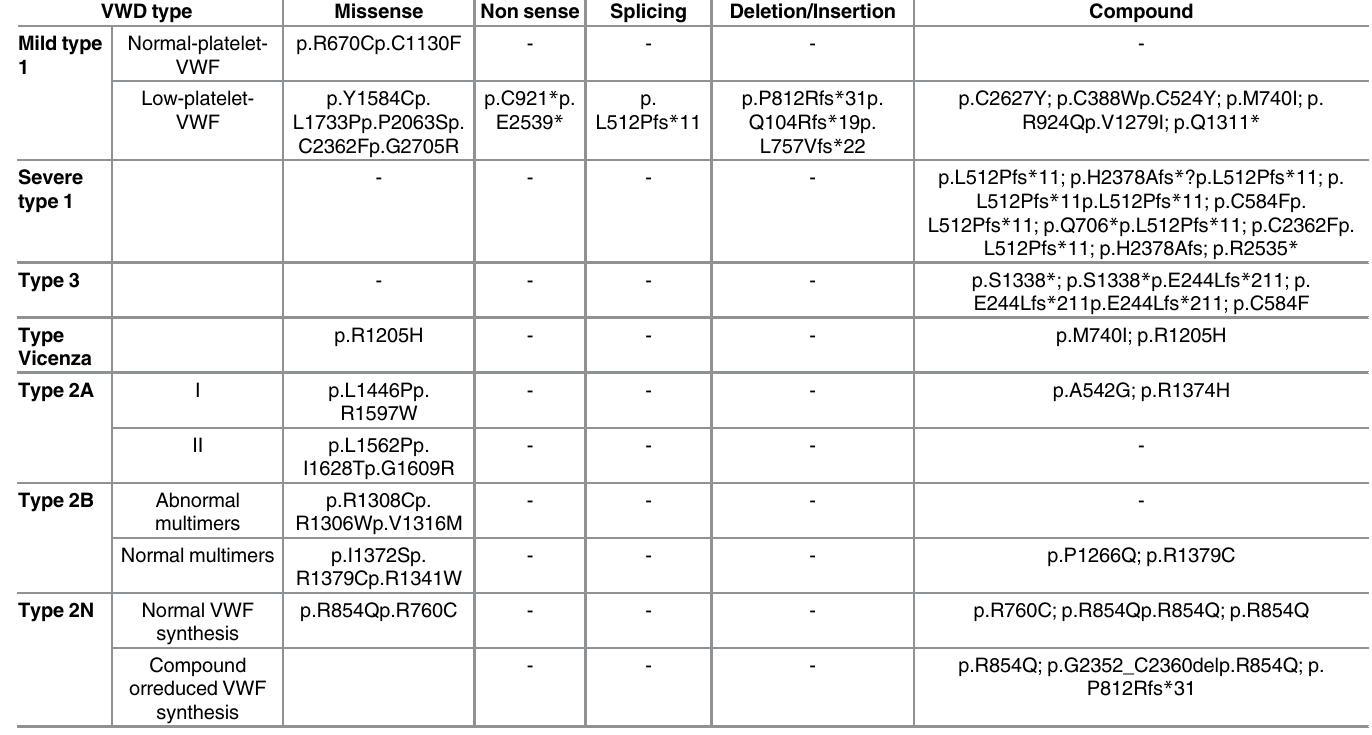
Table 2. Genetic mutations in the VWD patients